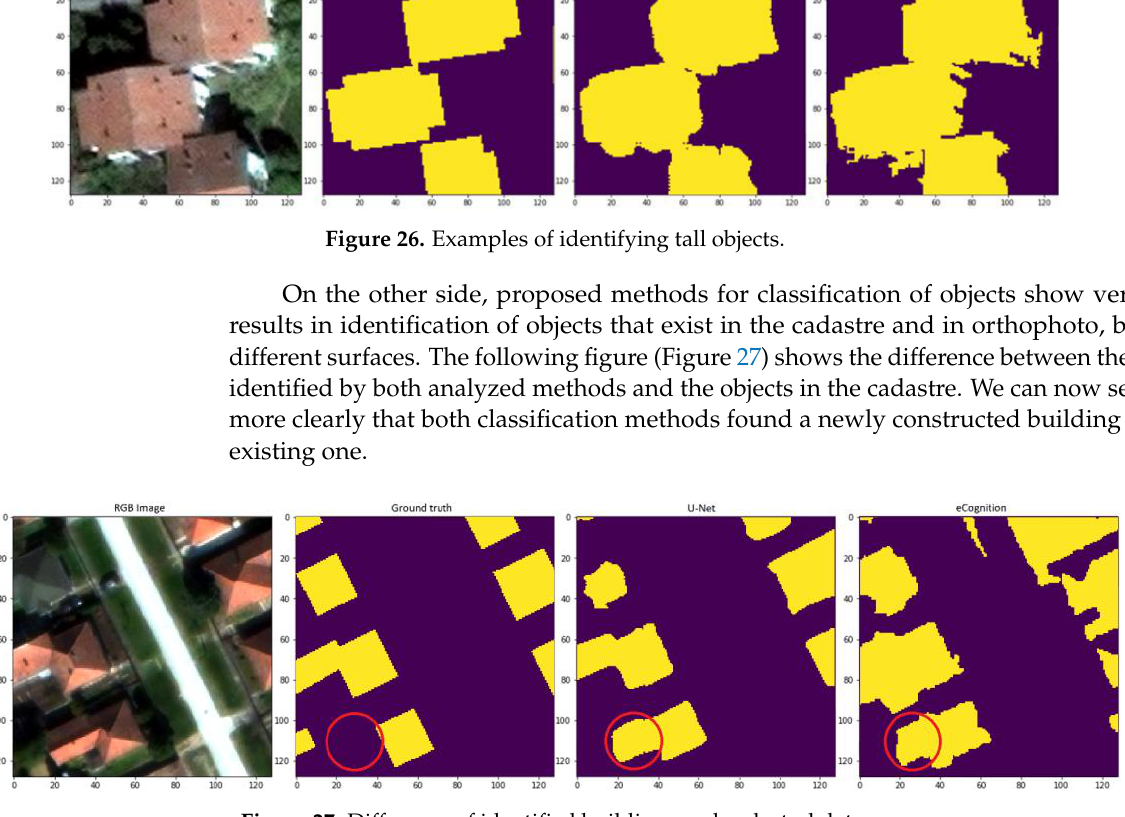
Figure 27. Difference of identified buildings and cadastral data.